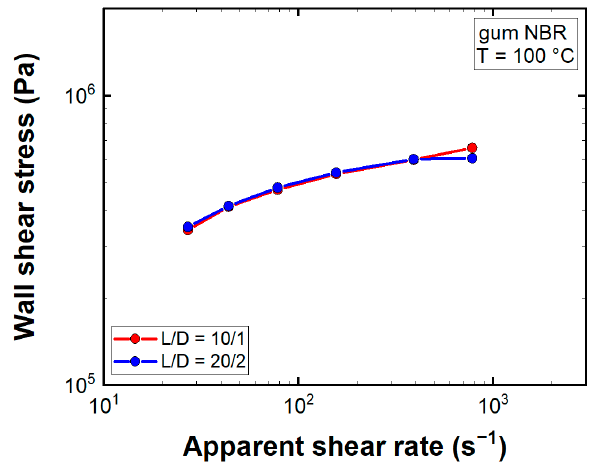
Figure 5. Entrance pressure corrected flow curves of two capillary dies with same length-to-diameter (L/D) ratios but different capillary diameters.